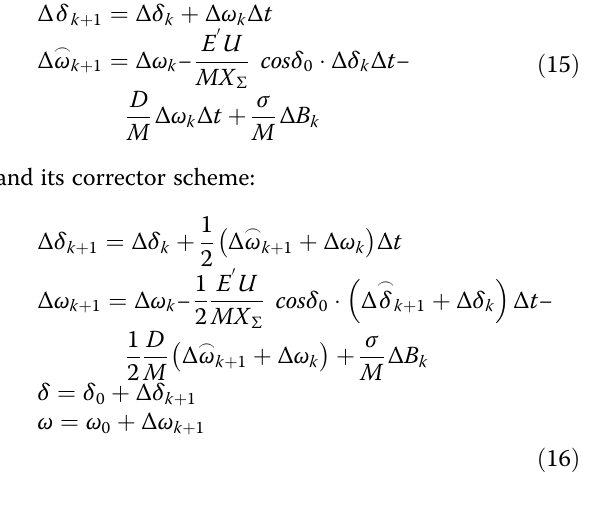
4 Algorithm stability